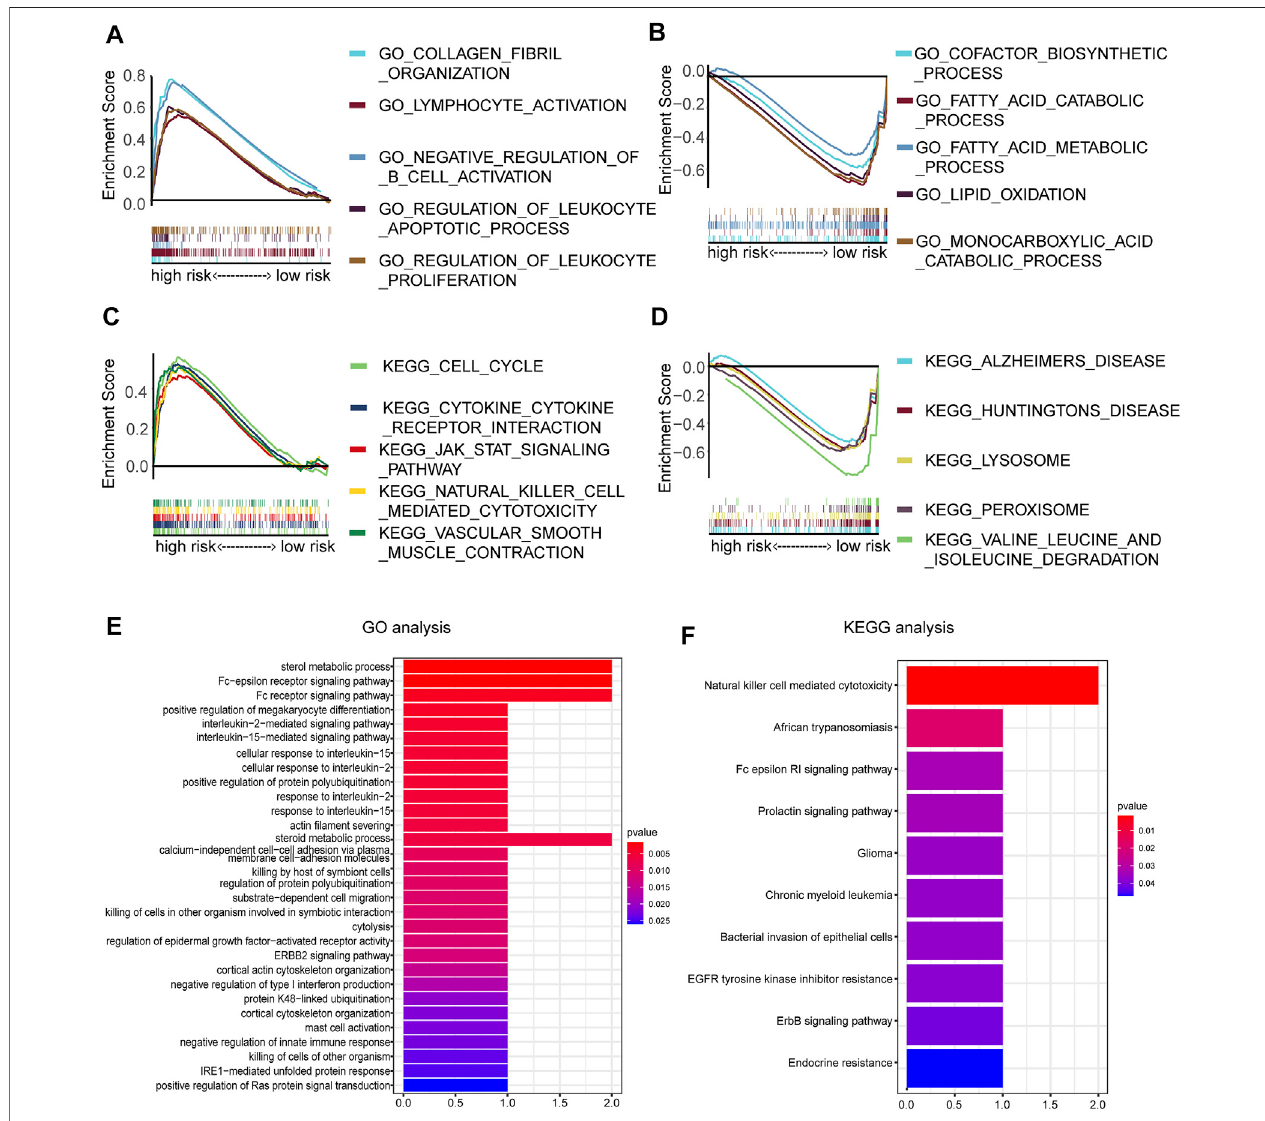
FIGURE7| Enrichment analysisof8DEMDGs. (A) Biological processes enriched inthehigh-riskgroups. (B) Biological processes enriched inthelow-riskgroups. (C) Signaling pathways enriched in the high-risk group. (D) Signaling pathways enriched in the low-risk group. (E) GO enrichment analysis of 8 DEMDGs in biological process. (F) KEGG enrichment analysis of 8